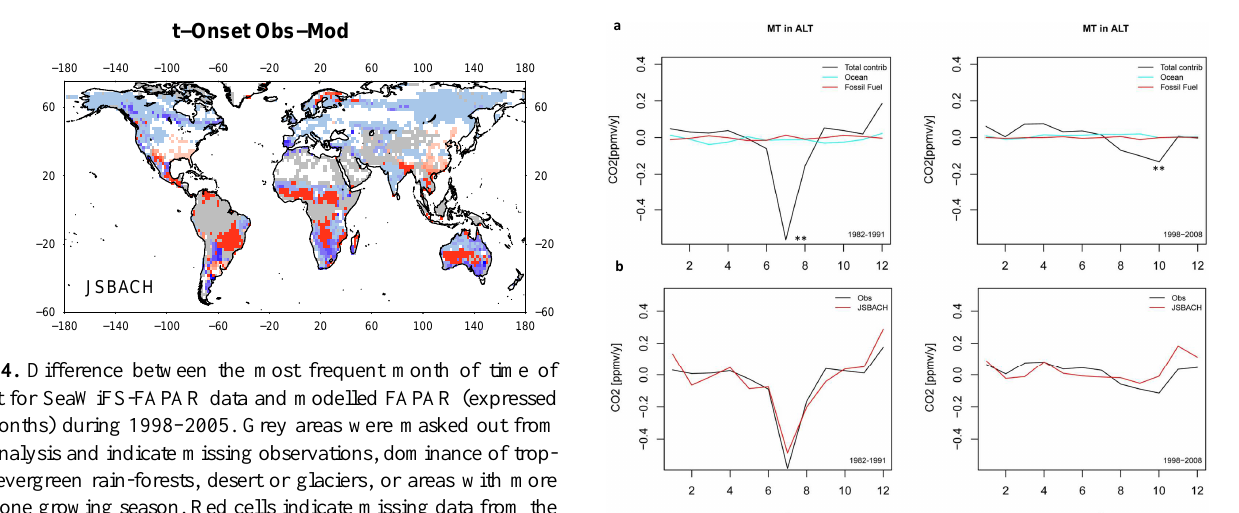
Fig. 5. Monthly CO 2 trend in the station of Alert (Canada, ALT) for the periods 1982–1991 and 1998–2008. (a) Observations, as well as simulated contribution from fossil-fuel emission and net ocean fluxes (** P < 0 . 01). (b) Monthly record for observations and mod- elled data. Negative values for a specific month indicate a decrease of seasonal atmospheric CO 2 , indirectly linked to an increase of biosphere C uptake, and vice